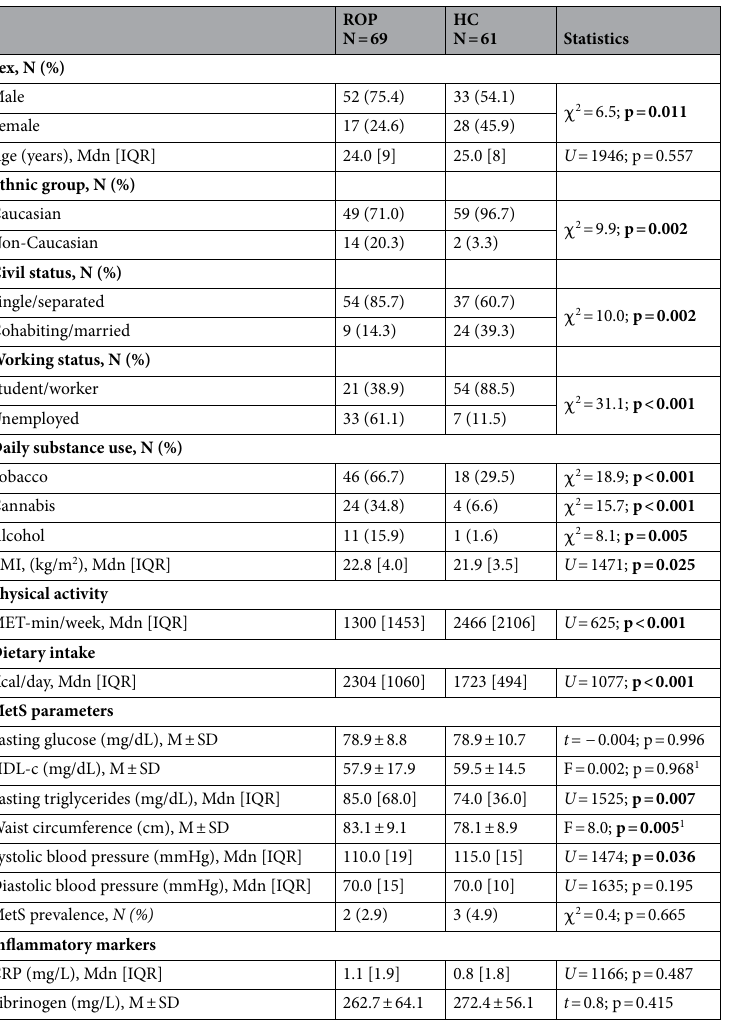
Table 1. Demographic and clinical data of the study sample. ROP recent-onset psychosis, HC healthy control, N number of cases; M mean; SD standard deviation, Mdn median, IQR interquartile range, BMI body mass index, MET metabolic equivalent task, MetS metabolic syndrome, HDL-c high-density lipoprotein cholesterol, CRP c-reactive protein. Significant differences are indicated in boldface. 1 Sex was considered in the comparison of